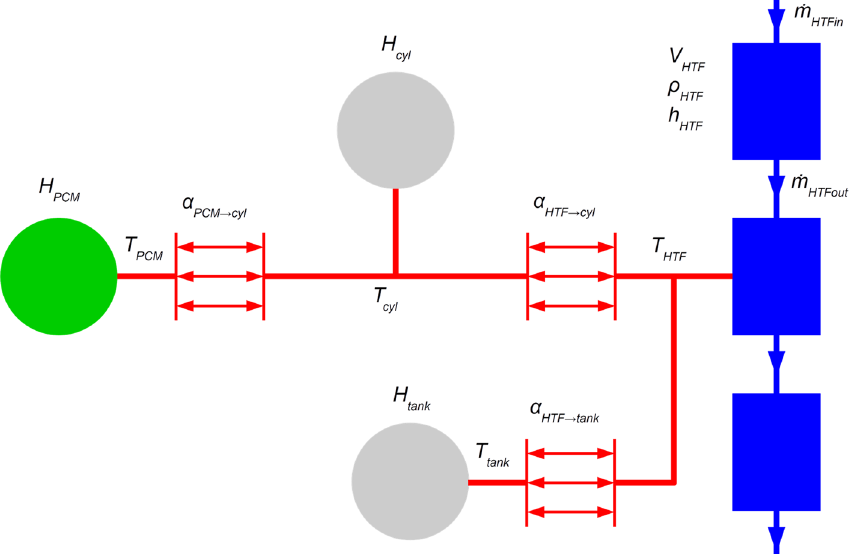
Figure 5. Topology of the lumped latent heat storage model with the HTF (blue rectangles), capacity of steel (grey circles), capacity of PCM (green circle), and heat transfer (red arrows)